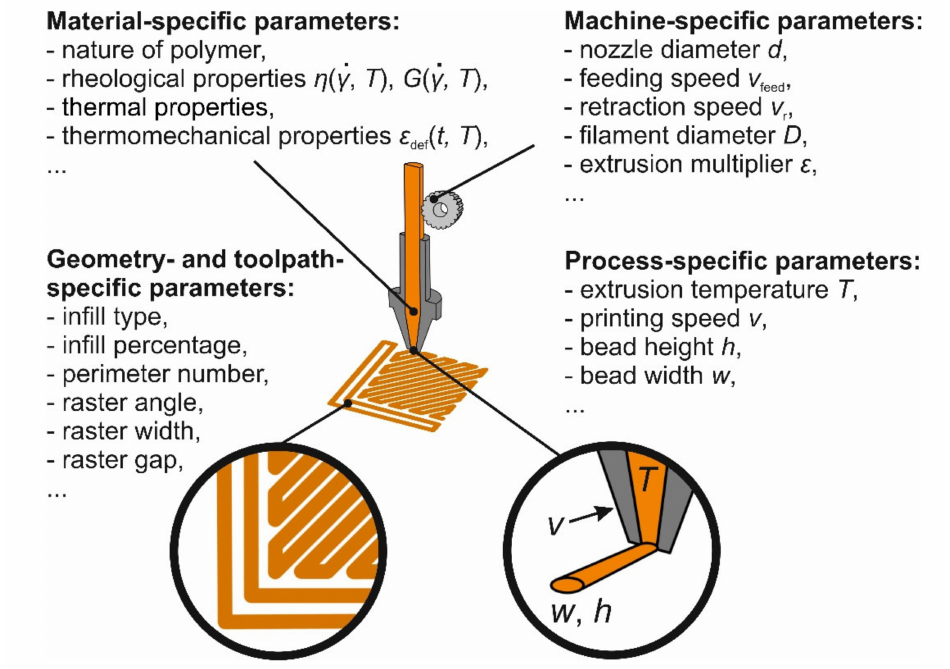
Figure 1. A diagram to illustrate di ff erent parameters in a material-extrusion-based additive manufacturing